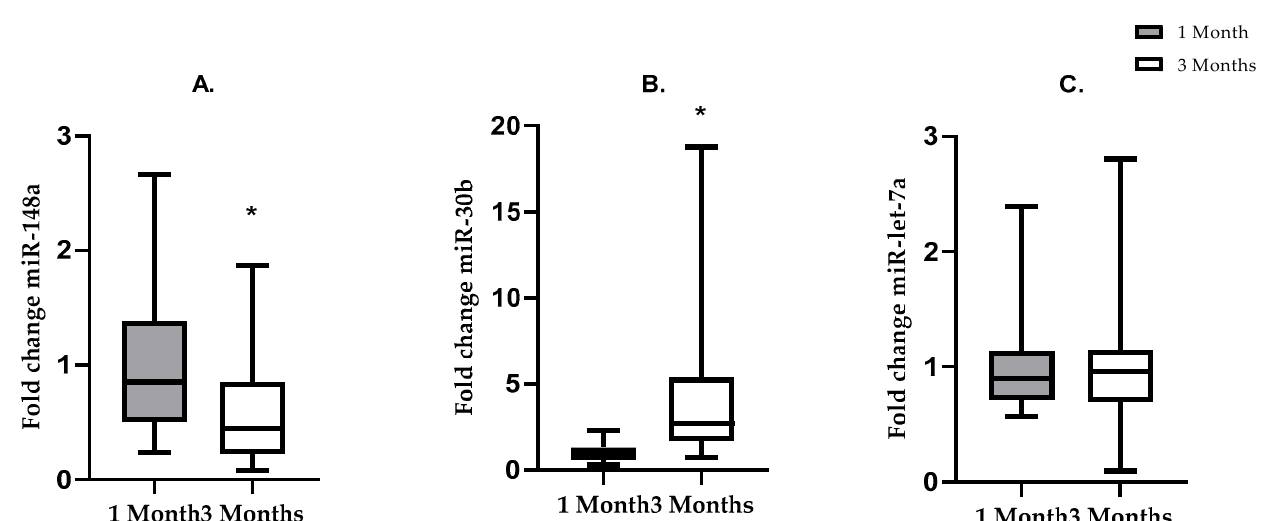
Figure 2. Changes in fold change of miRNAs from 1 to 3 months of lactation in all (both NW and OW/OB) mothers, without adjusting for maternal BMI. Grey bars show miRNA fold change at 1 month of lactation. White bars show miRNA fold change at 3 months of lactation. ( A ) Mean ± SD. * = p < 0.05: fold change expression of miR-148a was lower at 3 months than at 1 month of lactation ( t -test p =< 0.0001). ( B ) Mean ± SD. * = p < 0.05. Fold change of miR-30b was higher at 3 months than at 1 month of lactation (Mann–Whitney p =< 0.0001). ( C ) Mean ± SD. No difference in the fold change of miR-let-7a from 1 to 3 months of lactation (Mann–Whitney p = 0.842).